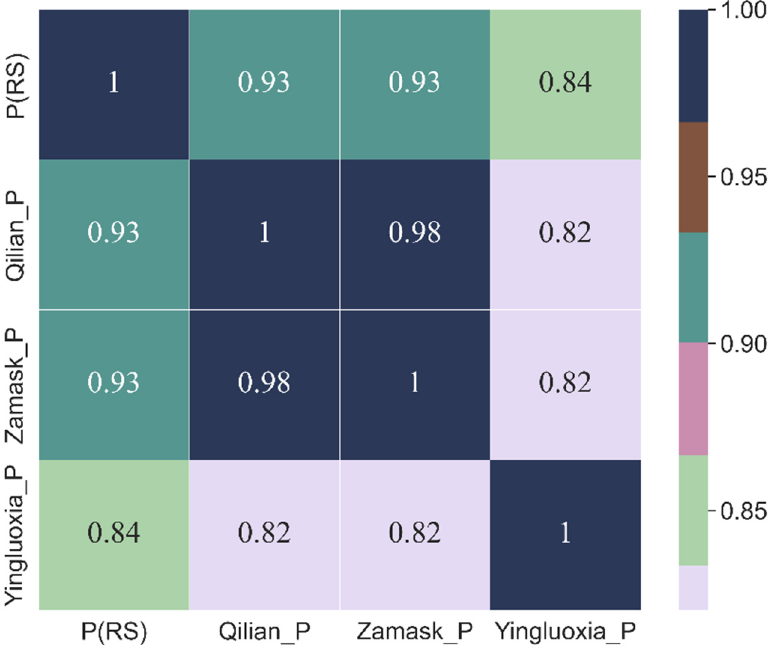
Figure 7. The correlation of P(RS) and in situ rainfall data. Both the x axis and y axis represent the rainfall data in three stations and remote sensing precipitation. The darker the color is, the greater the correlation coefficient and the stronger the correlation will be.